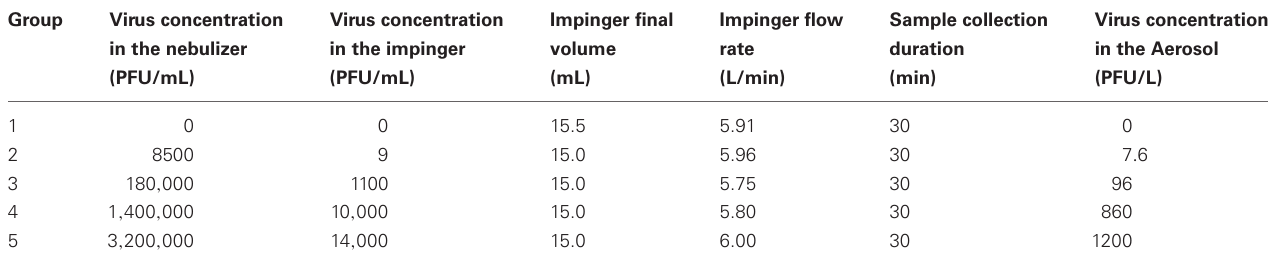
Table 1 | PR8 bioaerosol